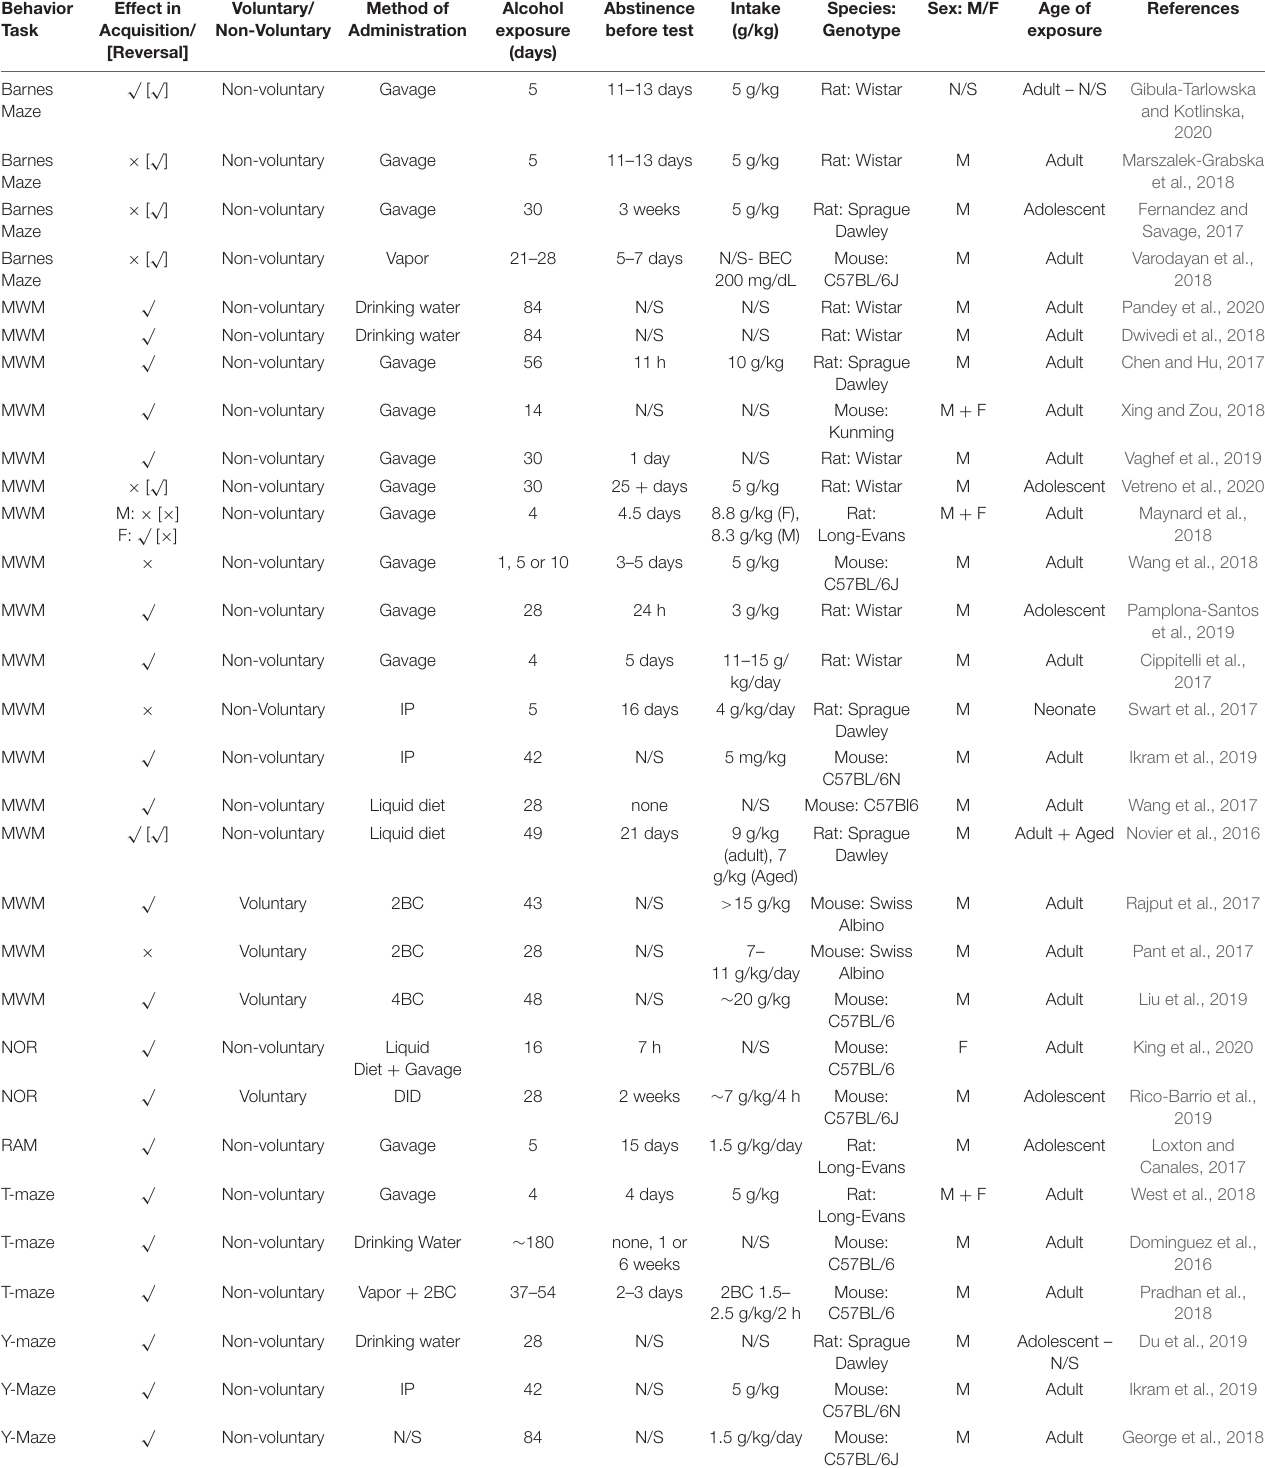
TABLE 1 | Spatial learning and retrieval summary from reviewed studies outlining behavior task, effect, methodology and subjects. Behavior